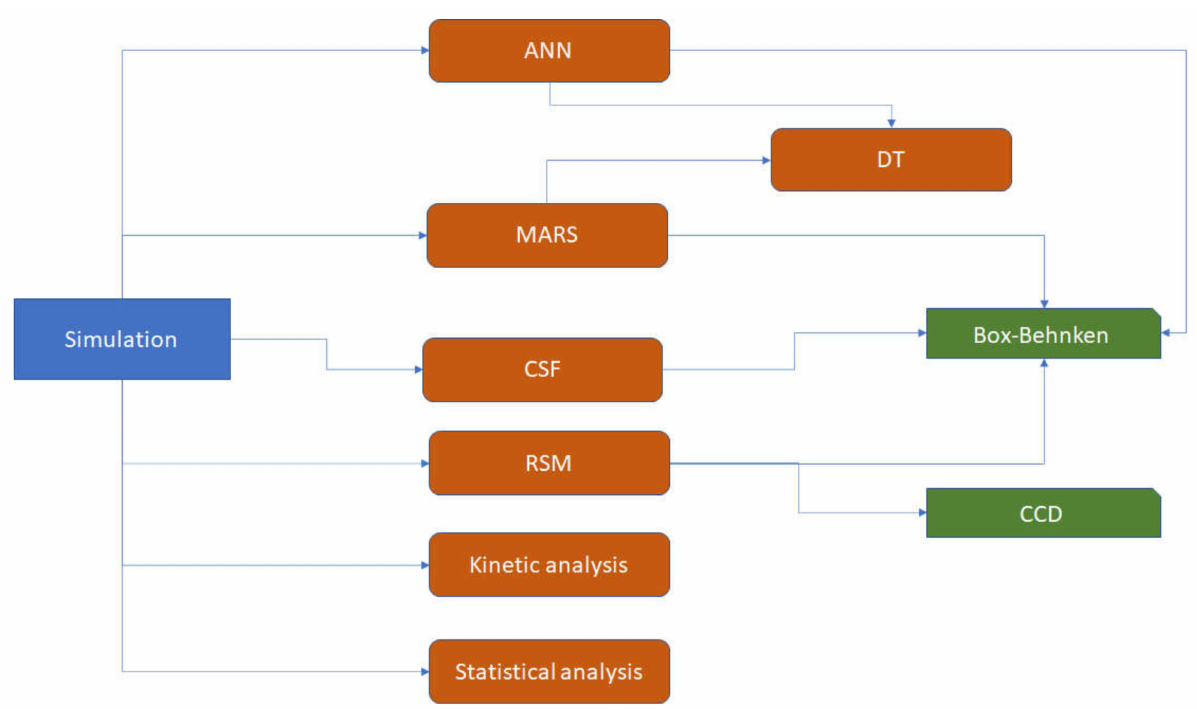
Figure 4. Simulation of wet torrefaction